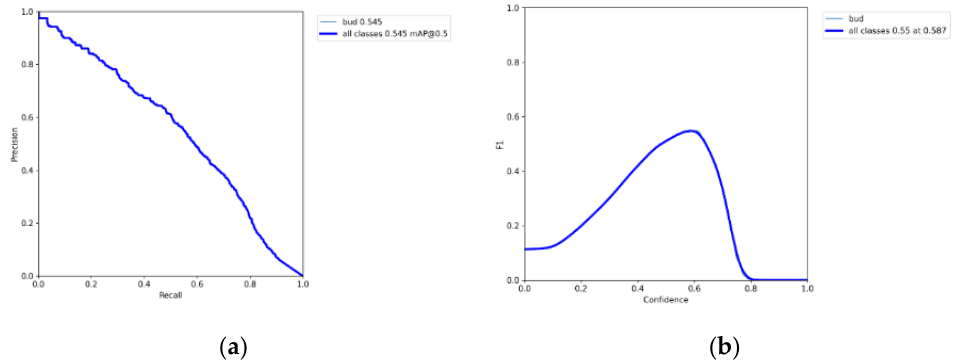
Figure A7. The changes of recall of YOLOV5m.